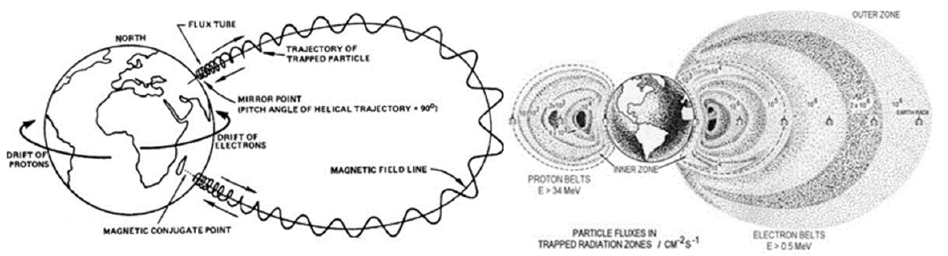
Figure 2. Gyration, bounce, and drift movement of trapped particles ( left ) [20] and flux densities of trapped electrons and protons ( right ) [21].